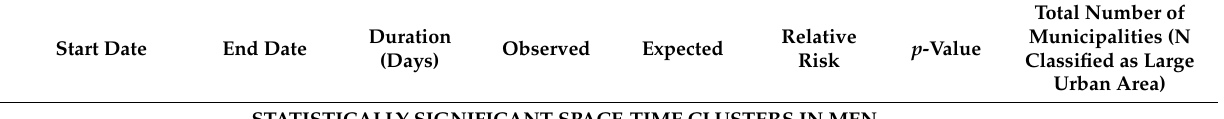
Table 2. Space–time significant clusters of hepatitis A in 15–49 years-old men and women, Spain,